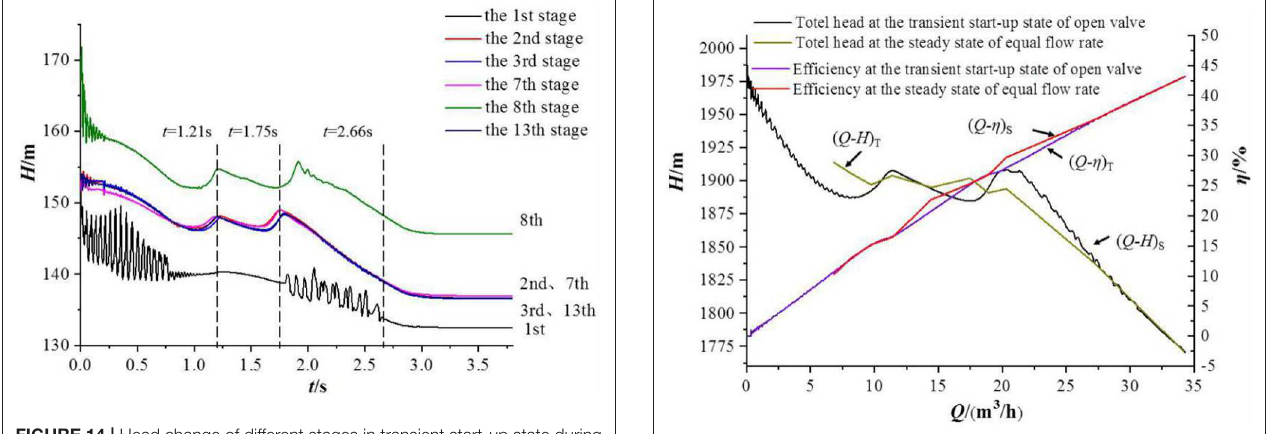
FIGURE 15 | Comparison of outer characteristics of start-up transient state and steady state of equal flow rate in open-valve stage. transition, when the open-valve transition starts in the middle and late development period 27.20 m 3 /h ≤ Q ≤ 34.20 m 3 /h, the flow efficiency curve and the flow head curve are basically the same. When Q ≤ 20.33 m 3 /h, there are three hump peaks